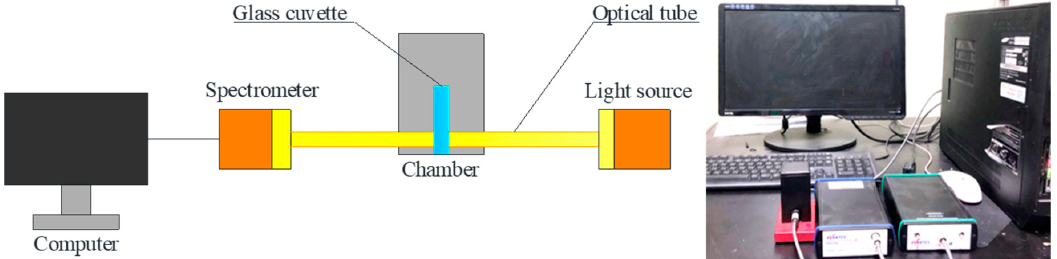
Figure 4. Schematics and picture of optical transmittance experimental setup.